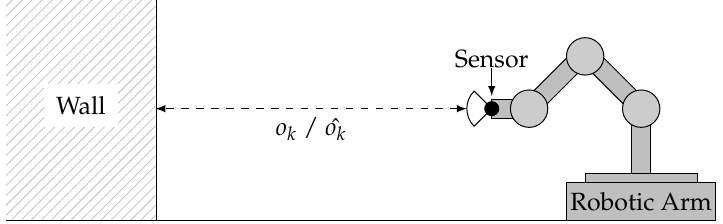
Figure 10. Evaluation setup to acquire real sensor data from a Sharp GP2D12 infra-red distance sensor.